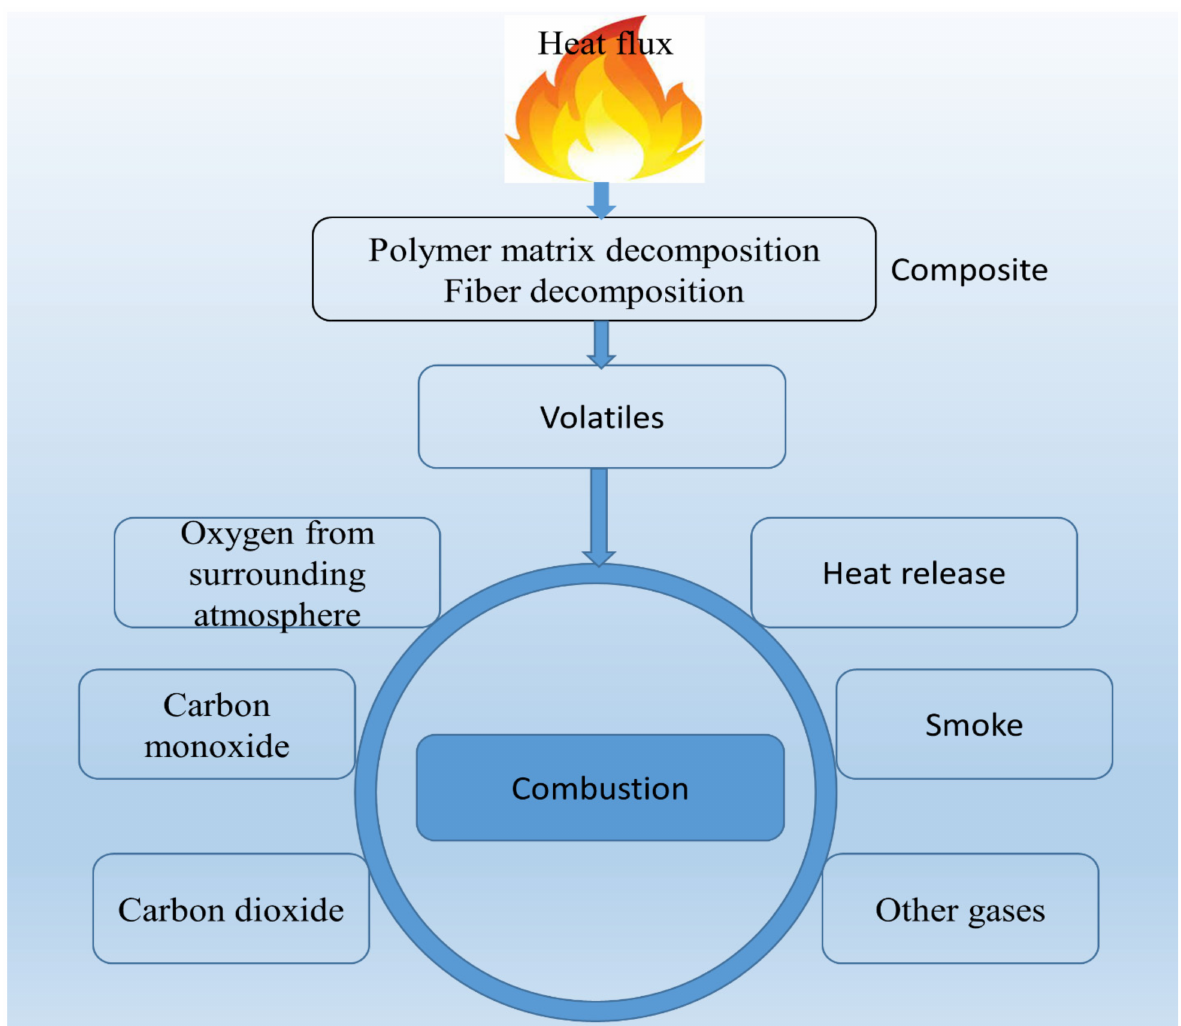
Figure 2. Reaction mechanism process in thermal decomposition of a polymer composites